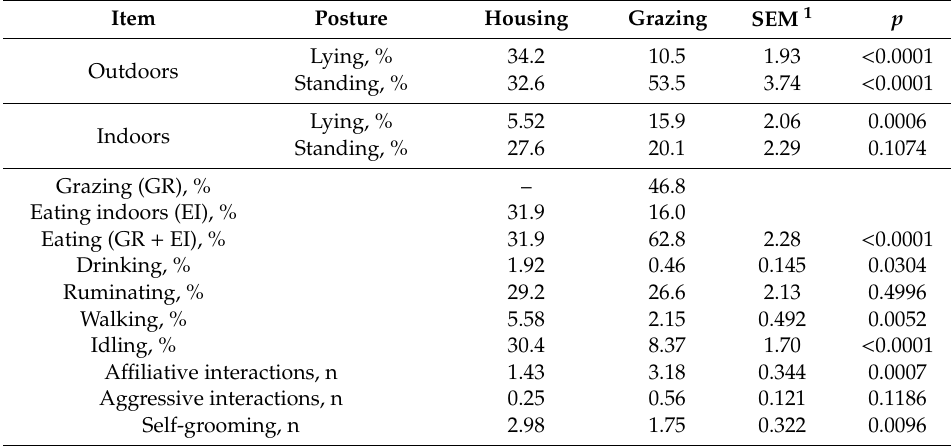
Table 2. E ff ect of feeding system on animal behaviour (% of observation time), social and aggressive interactions (n / cow).